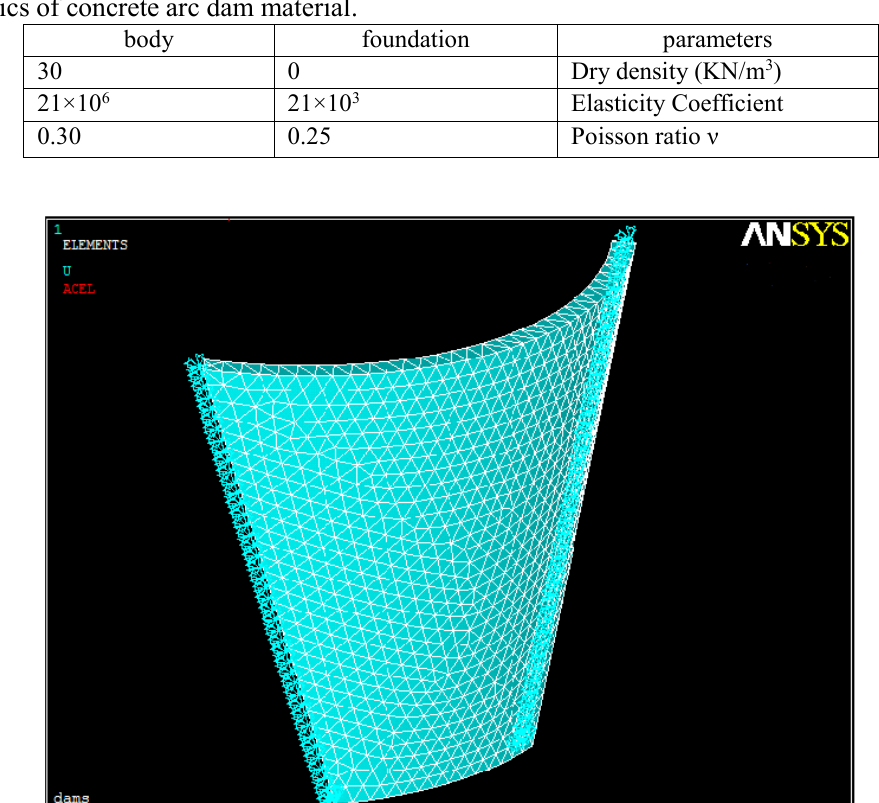
Fig. l. Geometrical model of the